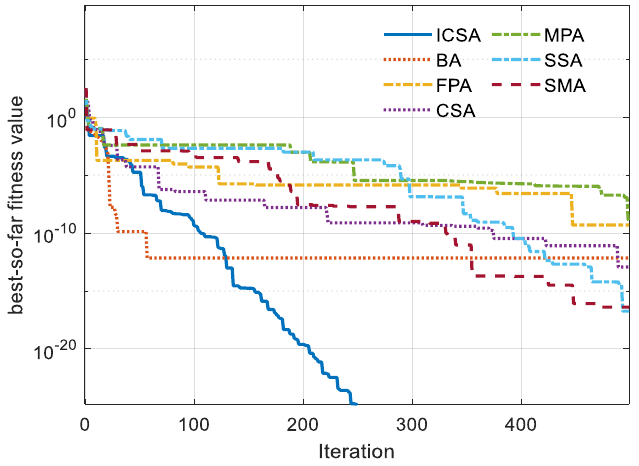
Figure 3. Convergence curve for F2.